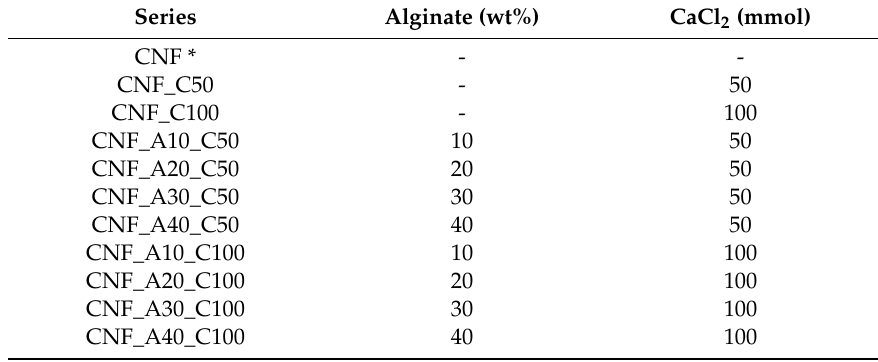
Table 1. Composition of the inks for three-dimensional (3D) printing. CaCl 2 : calcium